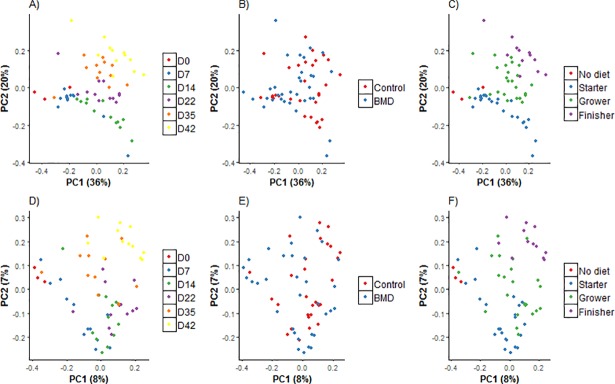
Principal coordinate analysis (PCoA) shows weighted (based on abundance; A-C) and unweighted (based on presence/ absence; D-F) pairwise UniFrac distances between samples of cecum microbial community with respect of age (d0, 7, 14, 22, 35 and 42), treatment (BMD-supplemented and BMD-free (control) and diet (no diet: d0 birds fed no diet, starter (fed from d0-22), grower (d23-d35) and finisher (d35-42).